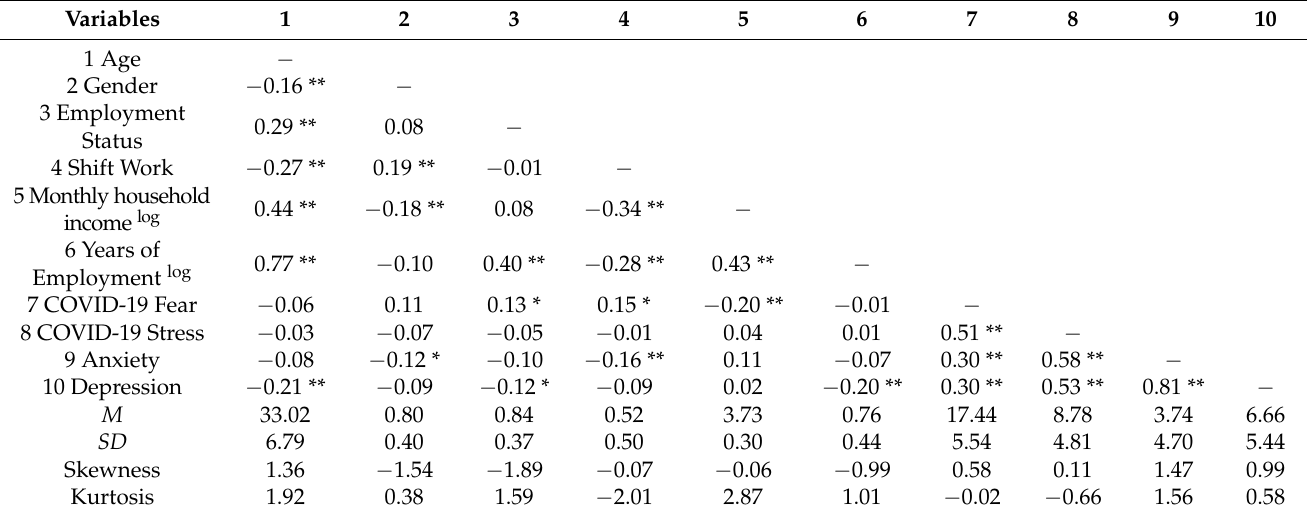
Table 1. Descriptive and Bivariate